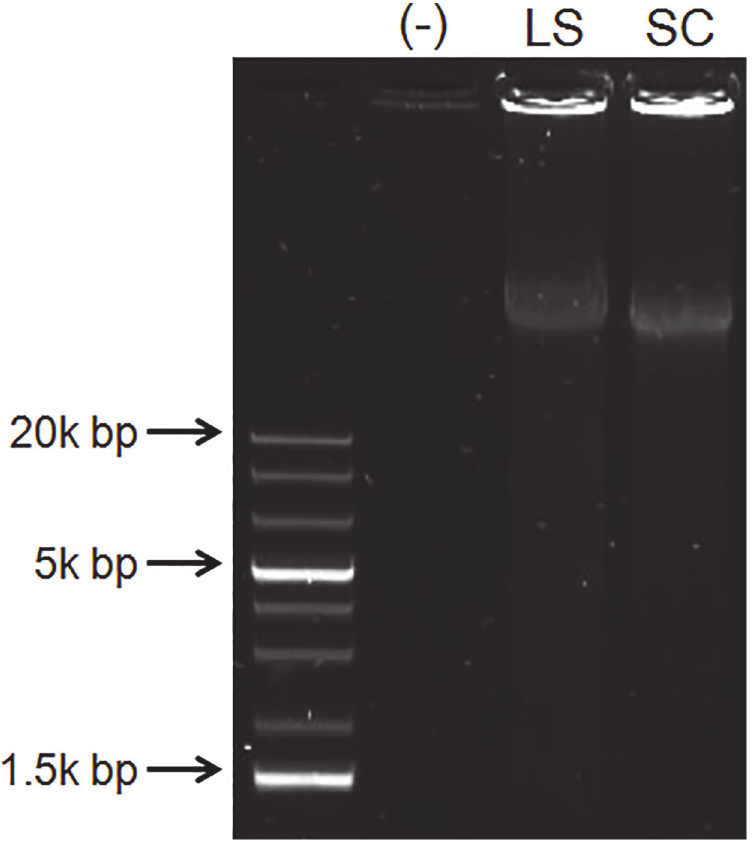
Fig 2. Synthesis of the Multi-Aptamers. Following a 10 minute RCA reaction, the LS- and SC-Multi- Aptamer DNA products were only generated in the presence of the primer (LS, SC). The negative sample (-) does not contain a